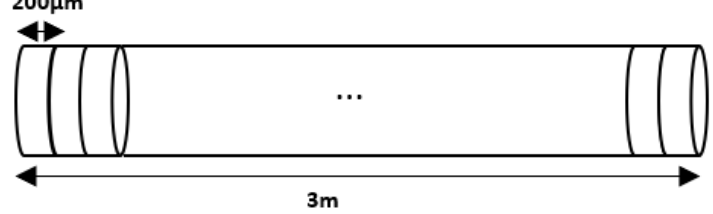
Figure 7. Impact of every slice from the laser